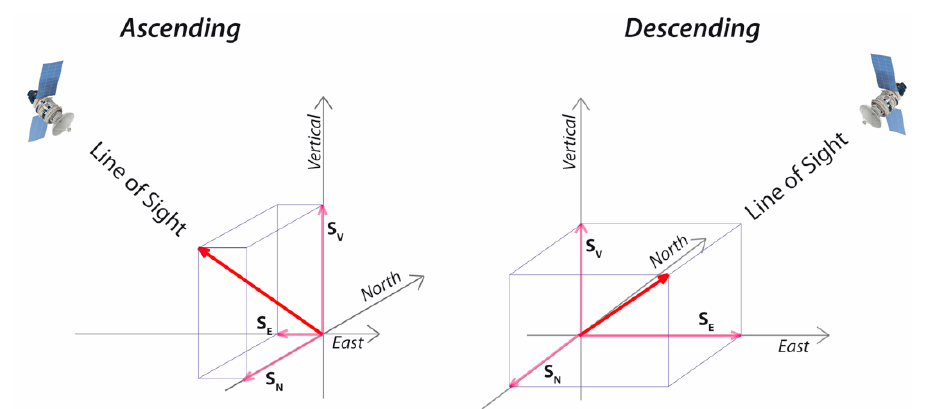
Figure 3. Representation of the cosine directors in both ascending and descending geometries for decomposing the LOS velocity in Vertical and Horizontal components.